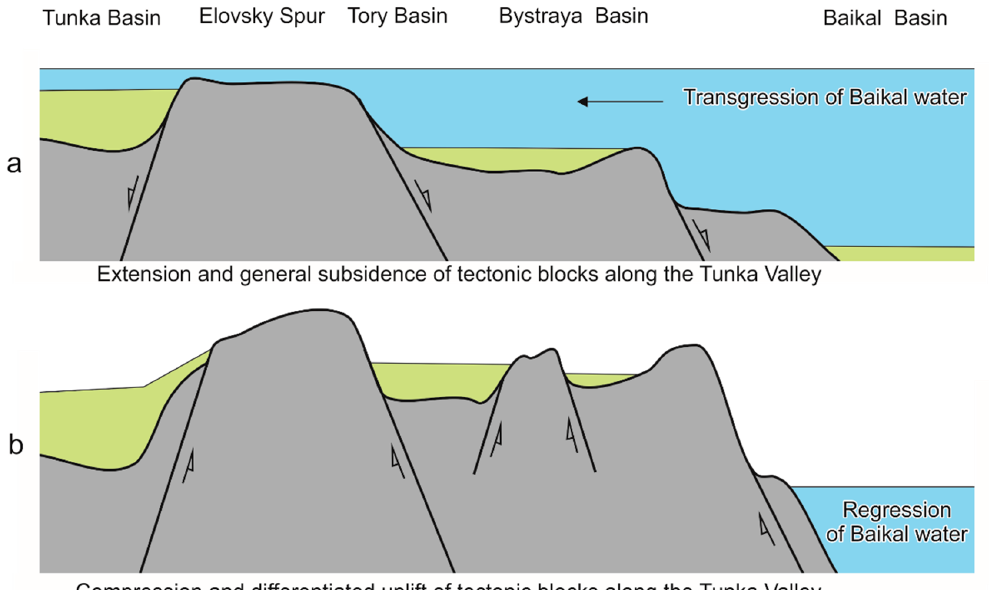
Figure 2. Possible tectonic scenario of transgression ( a ) and regression ( b ) of water from Lake Baikal into the Tunka Valley. Extension of the crust along the Tunka Valley results in a general subsidence of tectonic blocks by normal faults in the Miocene–Early Pliocene. Subsequent compression entails an inversion of tectonic motions with a differentiated uplift of tectonic blocks by reverse faults.